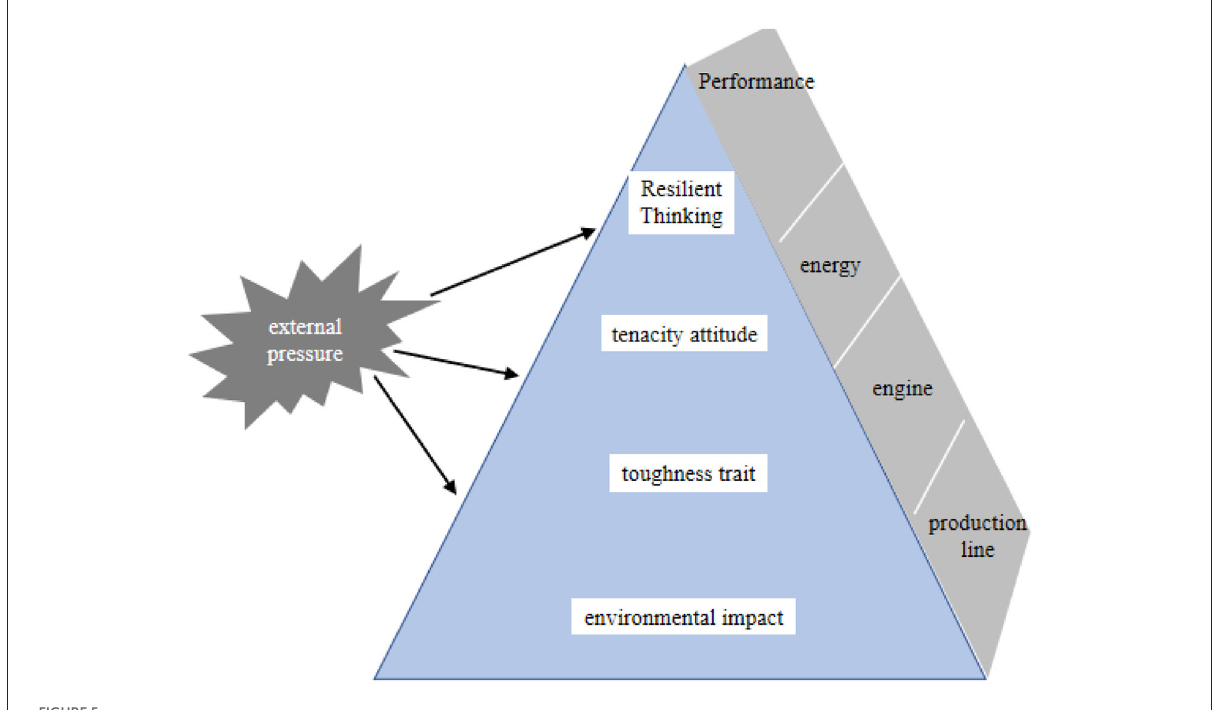
FIGURE5 Teacher salary satisfaction